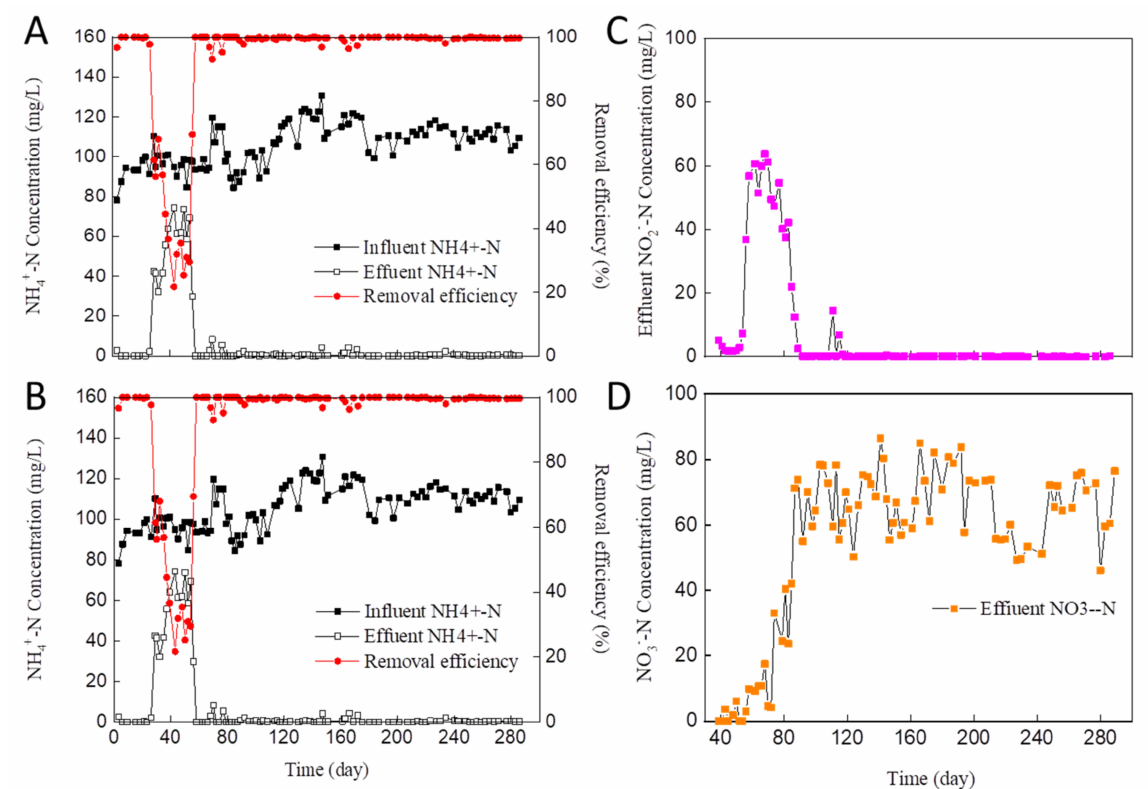
Figure 3. Performances of the aerobic granules during the long-term operation period: ( A ) COD removal; ( B ) ammonia removal; ( C ) nitrite production; ( D ) nitrate